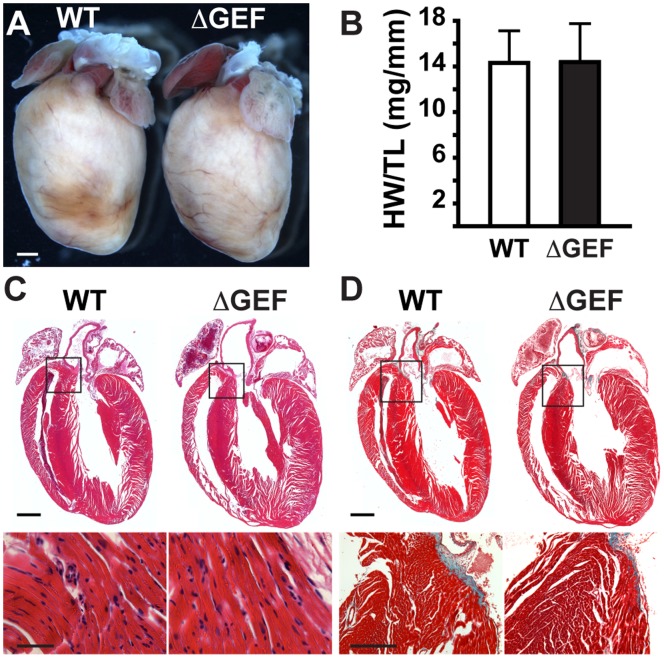
AKAP13-ΔGEF mutant mice had normal cardiac structure.(A) Hearts isolated from six wild-type (WT) and six AKAP13ΔGEF/ΔGEF (ΔGEF) adult male mice at 16–18 weeks of age had normal gross morphology; representative images shown. White scale bar is 1 mm. (B) WT and ΔGEF hearts were the same size as measured by heart weight to tibia length (HW/TL) ratios (in milligrams per millimeter). Means and standard deviations are graphed for six hearts of each genotype. Hearts were sectioned for histology and stained with (C) H&E or (D) Masson’s trichrome. The bottom panels of C&D are higher magnifications of the boxed regions in the top panels. (C) Cardiac structure was normal in ΔGEF hearts (top), and cardiomyocytes had proper organization (bottom). (D) ΔGEF hearts had normal levels of fibrosis as assessed by Masson’s trichrome staining. Black scale bars in C&D are 1 mm (top), 50 µm (C bottom), and 250 µm (D bottom).